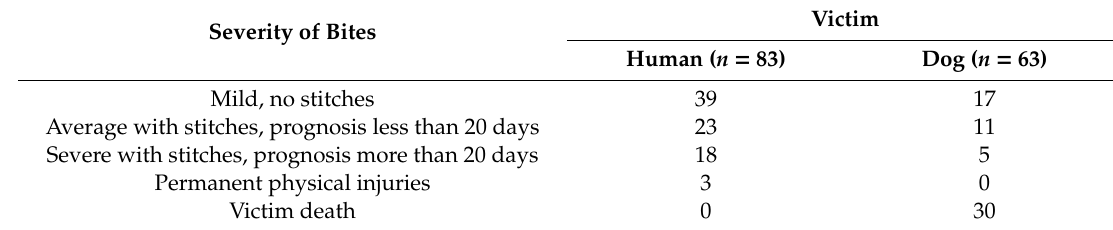
Table 20. Comparisons between the type of victim and severity of bites.